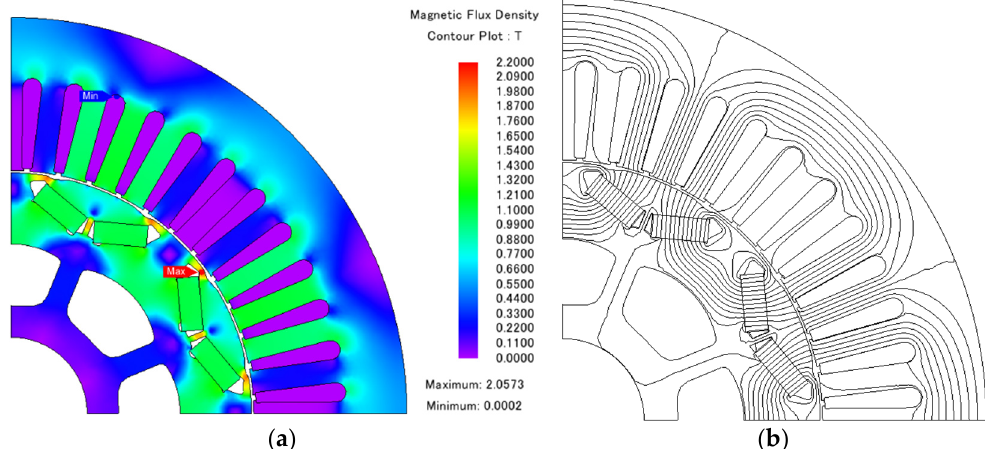
Figure 11. Flux distribution of Prius 2010 machine under OC condition: ( a ) contour; ( b ) flux line